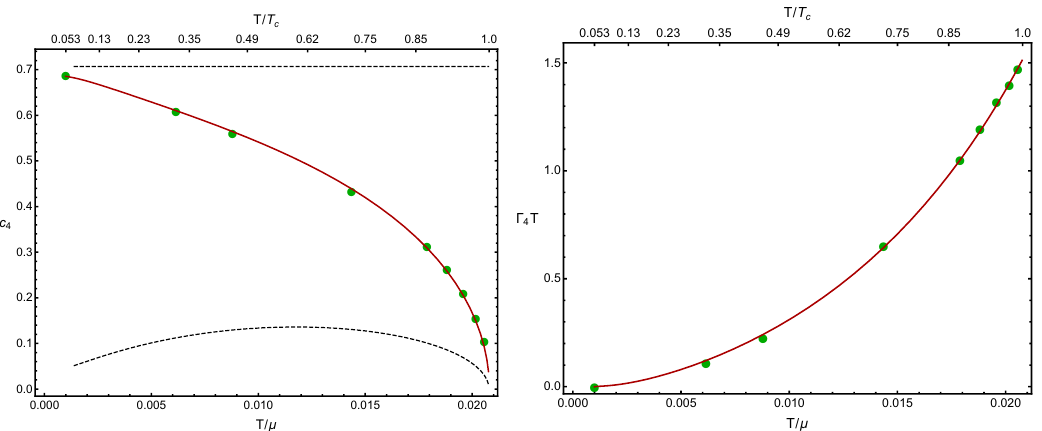
Figure 4 . The propagation speed and the attenuation constant of fourth sound in function of T/T c below the critical temperature for α/µ = 0 . 1 . The red lines are the hydrodynamic formulas (2.6) and the colored circles the numerical data extracted from the QNMs. The dashed lines in the left panel are the speed of first and second sound for α/µ = 0